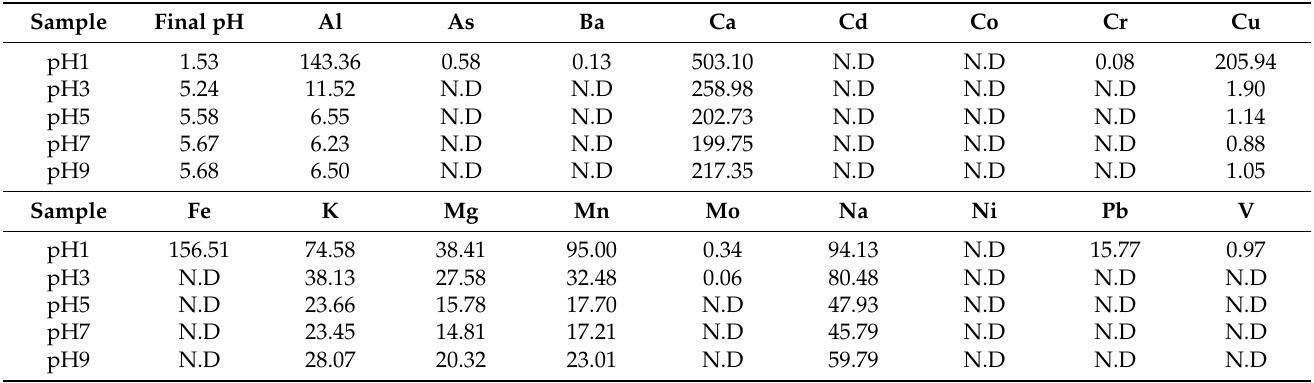
Table 3. Leaching results of heavy metals elements from the WFD at various pH values by the modified KSLT (unit: mg/L, N.D: Not detected).